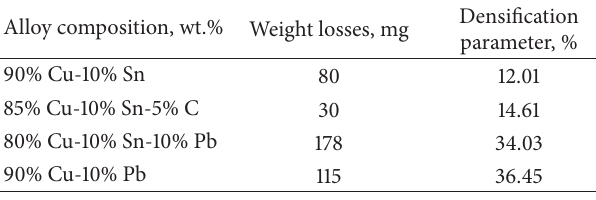
Table 2: The weight losses in mg at sliding distance of 1.258 km and contact pressure of 1.2 MPa and the densification parameter for all Cu-based alloys.